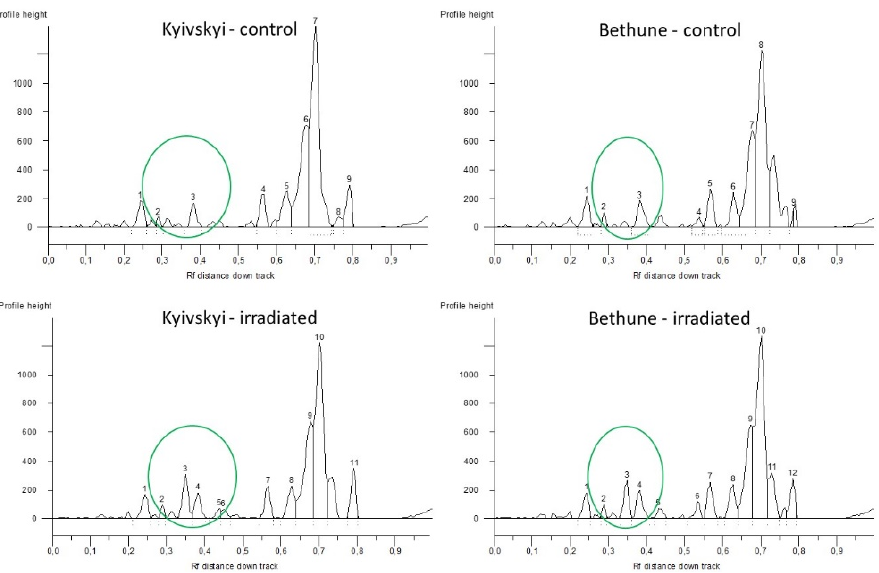
Figure 6. Comparison of obtained IRAP profiles of common flax varieties Kyivskyi and Bethune grown in the remediated and radio-contaminated field conditions of Chernobyl. x axis—Rf distance down track; y axis—profile height. 1–12—numbering of the generated loci.